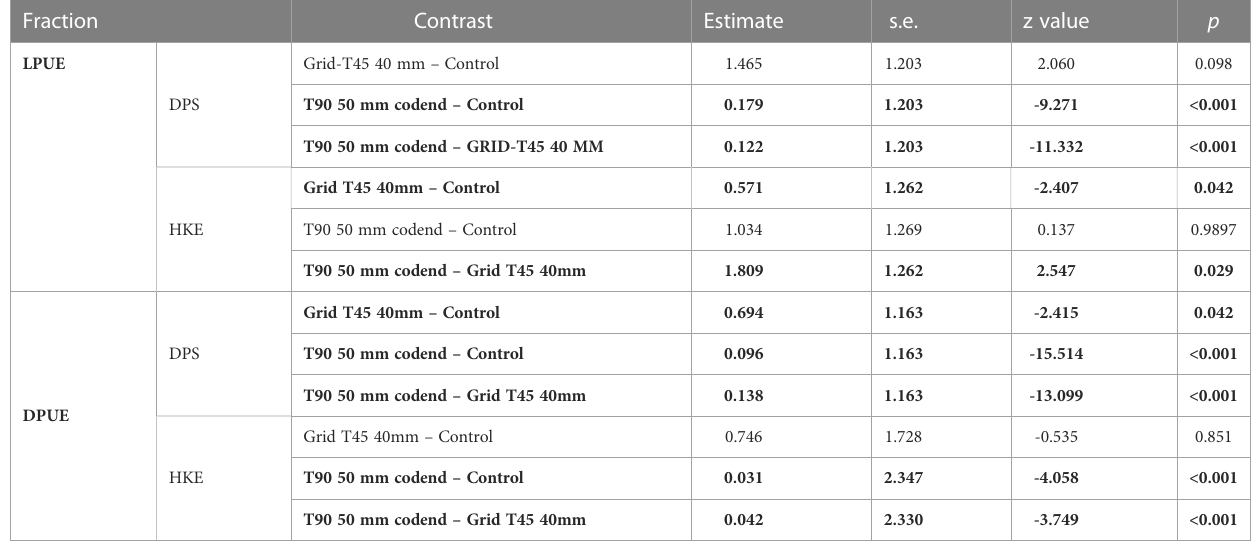
TABLE 3 Outcomes of the Tukey HSD post-hoc test of the catch rates of DPS and HKE, classi fi ed in catch fraction (commercial, LPUE and discard, LPUE), among different gear. Fraction Contrast